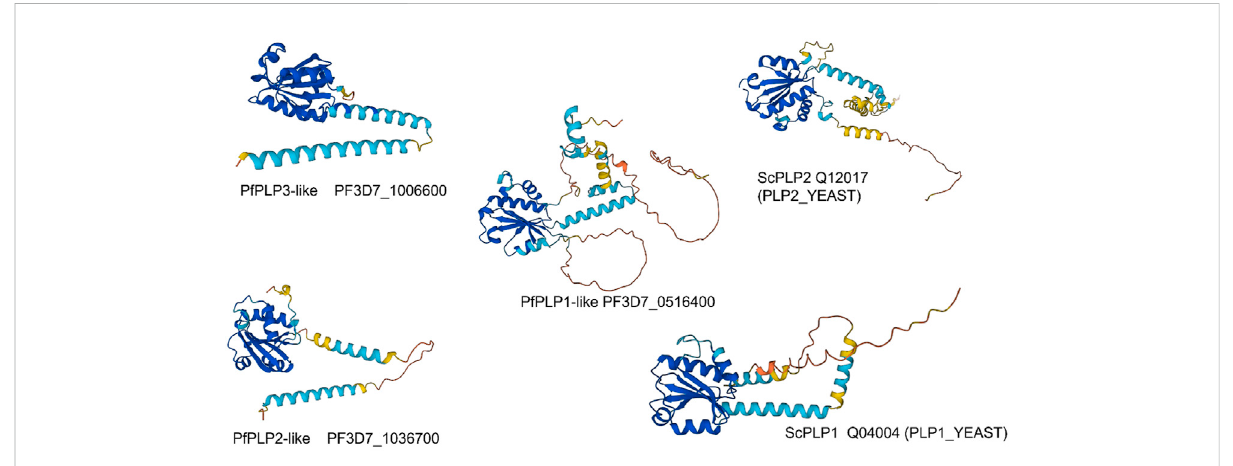
FIGURE 8 AlphaFold models of Phosducin-like proteins — P. falciparum v. Saccharomyces cerevisiae